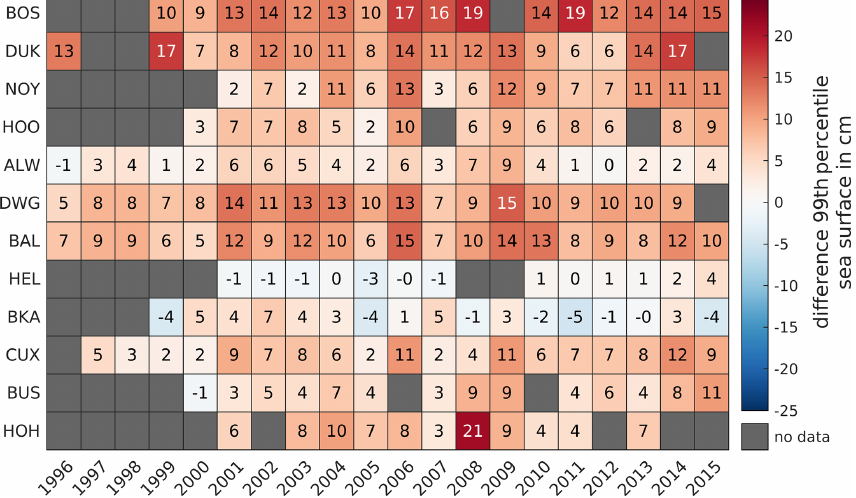
Figure 13. Difference in the 99% water level quantile in centimeters between 1996 and 2015 at representative gauges with positive values indicating water level overestimation by the